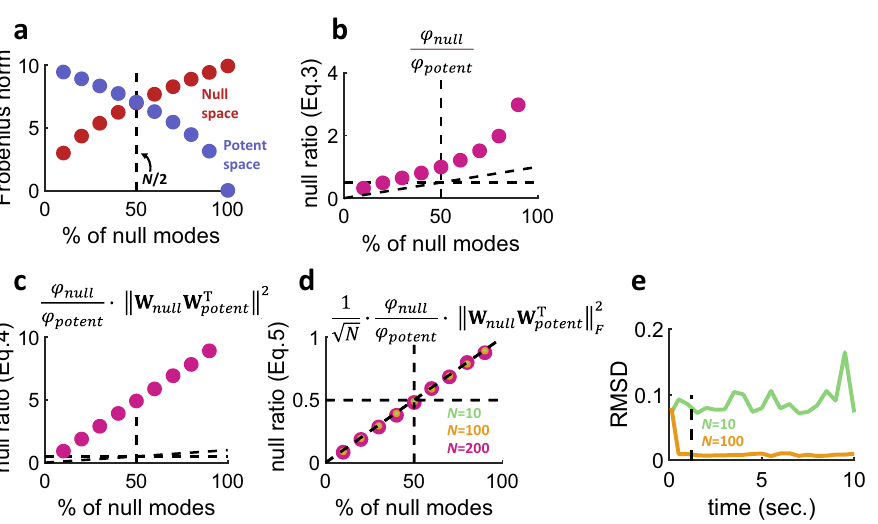
Figure 5. Estimating the null and potent space of neural communication. ( a ) The Frobenius norm of the null and potent space of connections W 0 intersected at a location where approximately half of all modes are null ( N = 100). ( b ) The ratio of null and potent neural modes (Eq. (3)) provided an estimation of the proportion of null modes in the model, but also generated unwanted nonlinearity. ( c ) Correcting nonlinearity by adding a term to the ratio (Eq. (4)) led to an overshoot in prediction. ( d ) The overshoot in prediction was corrected by scaling the estimation with a factor inversely proportional to the square root of N (Eq. (5)). ( e ) Root mean square difference (RMSD) between actual and estimated null ratios across different durations of simulation. Vertical dashed line: one second of